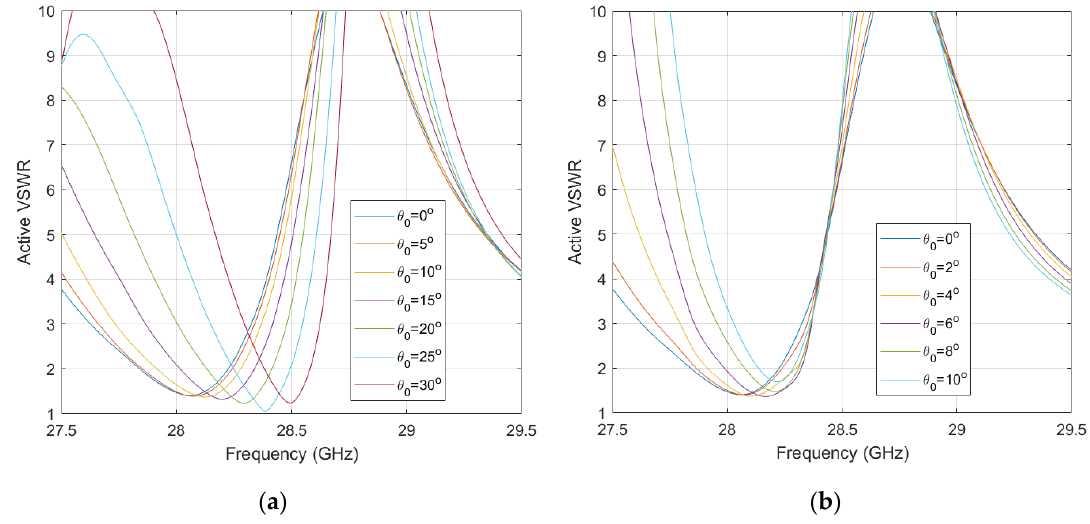
Figure 9. Active voltage standing wave ratio (VSWR) versus frequency and scan angle for ( a ) H-plane and ( b ) E-plane of the central sub-array of the 11 × 5 array.